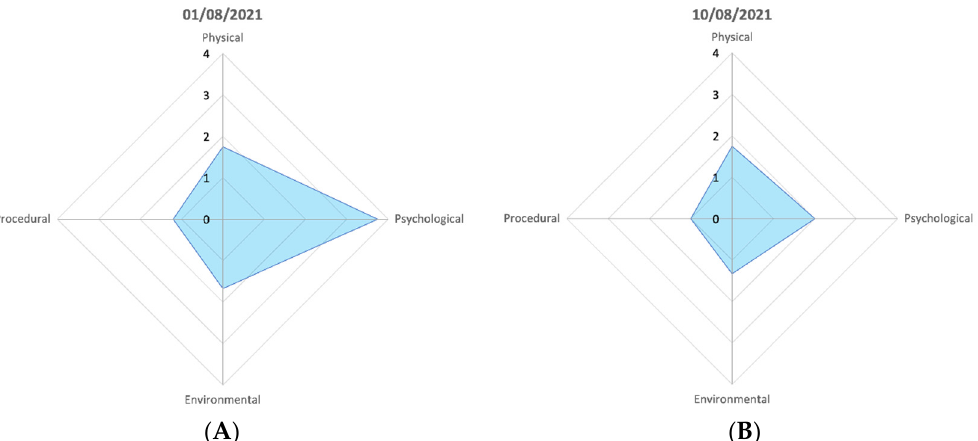
Figure 5. Individual animal welfare assessment grid of the common octopus, the parameter scores of the two greatest peaks in the data. ( A ) shows the parameter scores when a change of keeper and late feeding occurred, ( B ) shows the presence of the same different keeper but a normal feeding time. The shape of the polygon in each is the same but at different magnitudes of change.